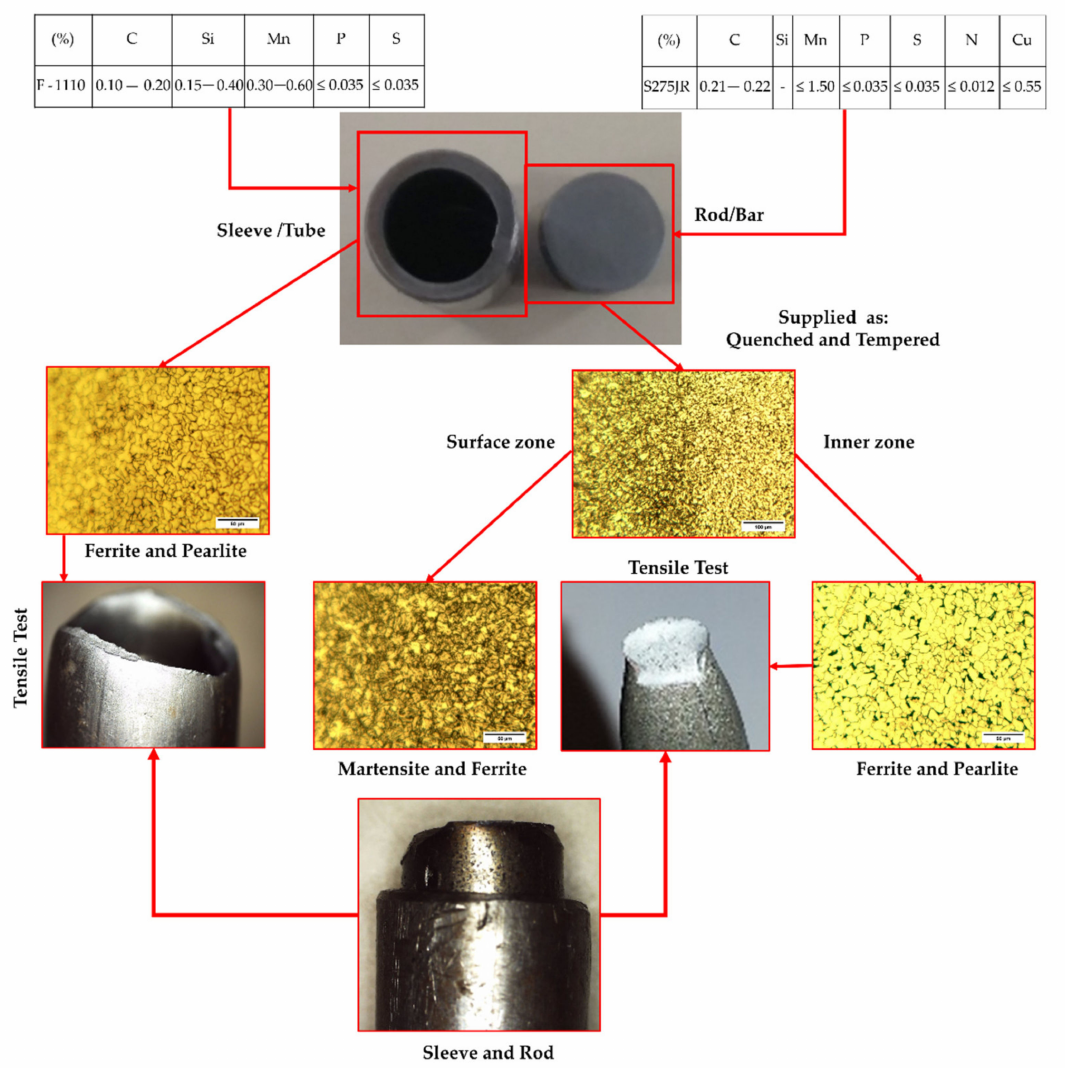
Figure 5. Metallurgical characterization of the sleeve and